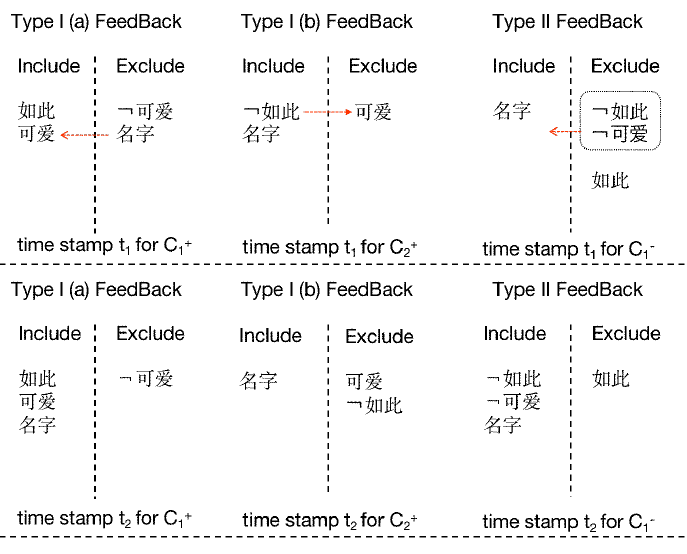
Figure 6. Learning process of Tsetlin Machine.